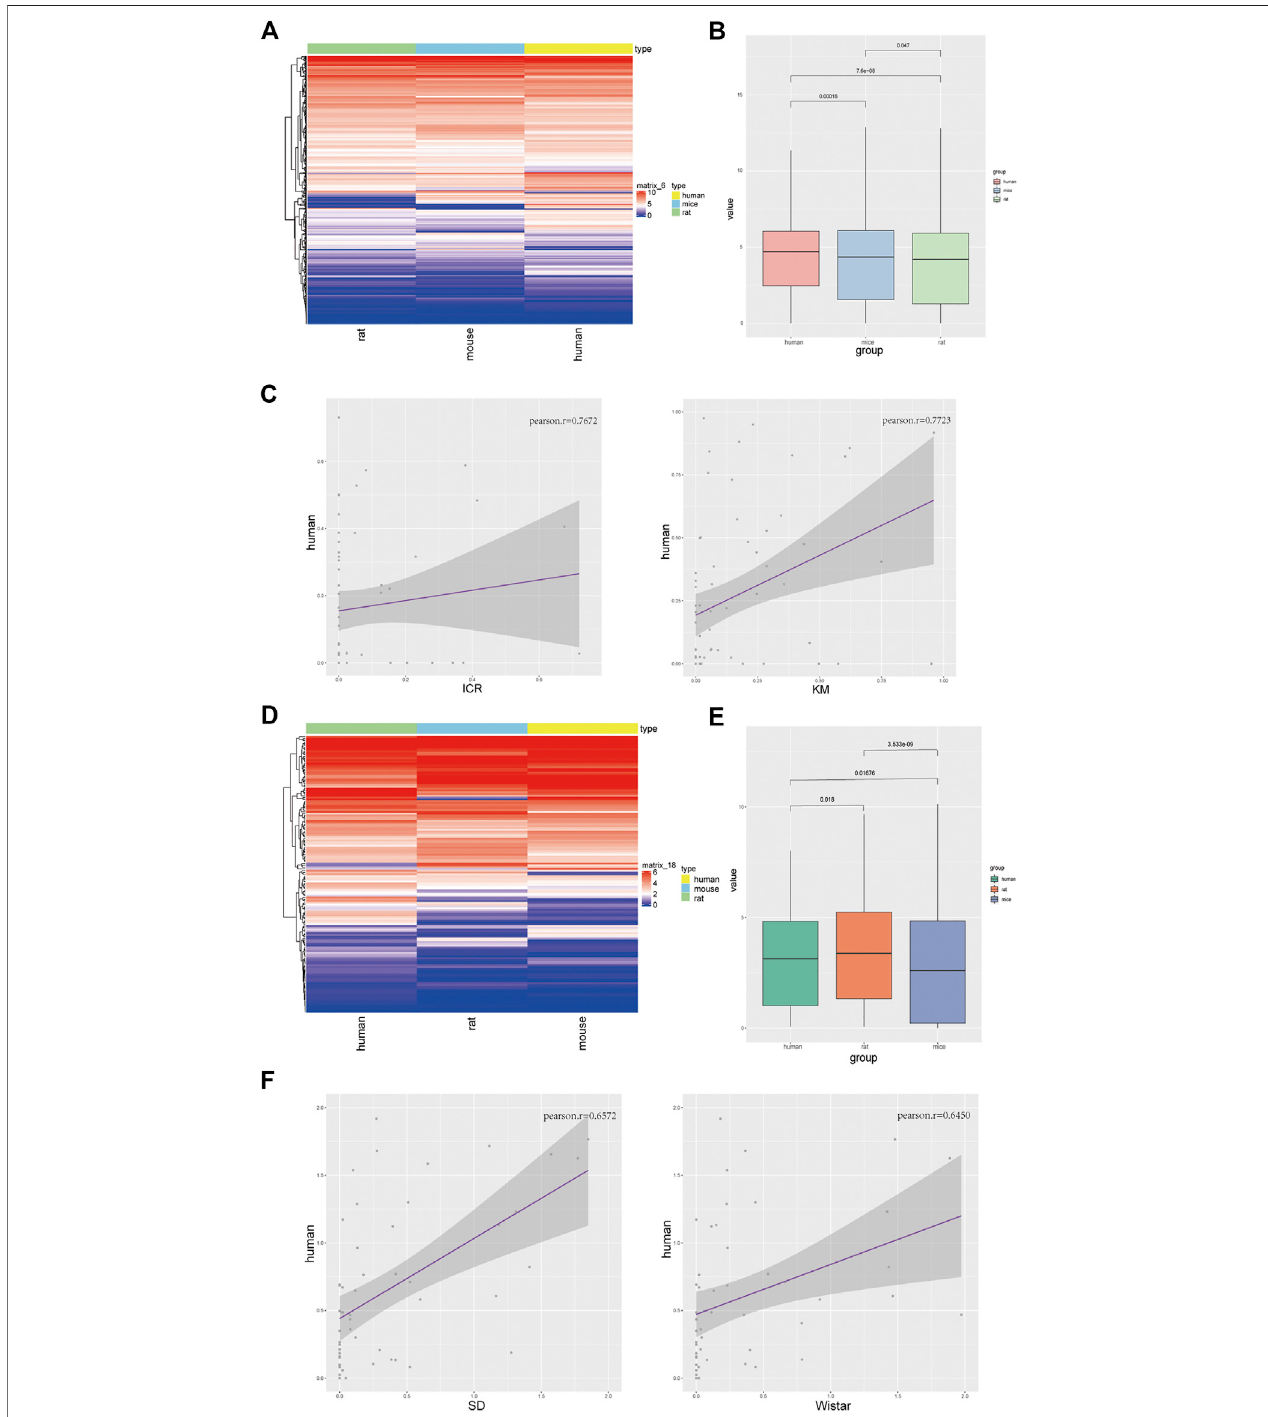
FIGURE 1 | Homologous genes in liver tissues of different strains of mice and rats are mainly related to hepatic function. (A) PCA pro fi le of homologous gene expression in mice and rats; (B) Correlation and clustering of homologous gene expression pro fi les of mice and rats (Supplementary Table S1) ; (C) Volcanic map showing the differentially expressed genes of ICR and Kunming mice (left) , KEGG pathways of co-expressed genes (right) ; (D) Volcanic map showing the differentially expressed genes of Sprague-Dawley (SD) and Wistar (WS) rats (left) , KEGG pathways of co-expressed genes (right) .